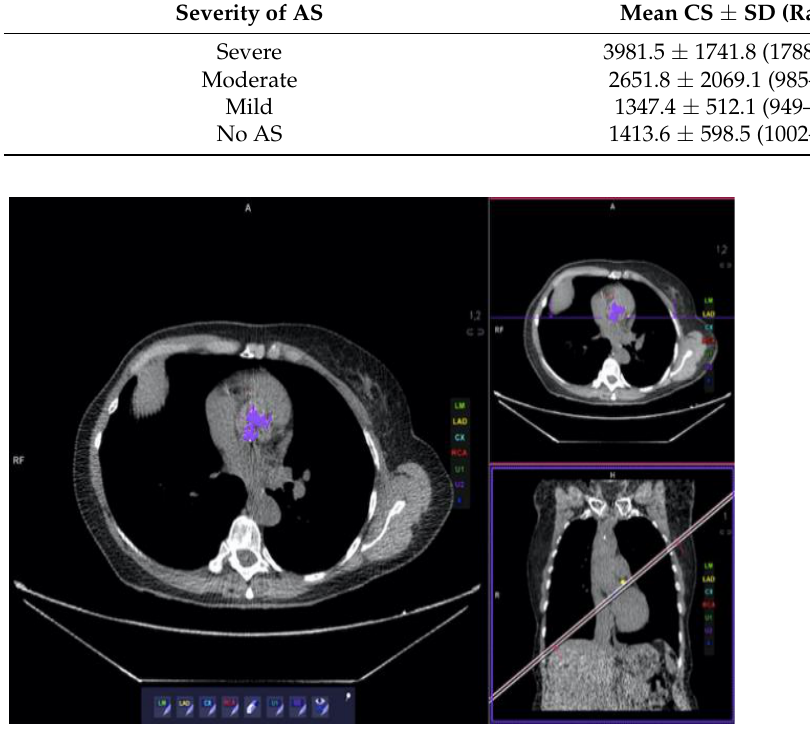
Figure 2. Patient with massive calcification. The calcium score was 4075. In echocardiography, severe aortic stenosis was diagnosed. Table 1. Study population characteristics. CS — calcium score, AS — aortic stenosis.